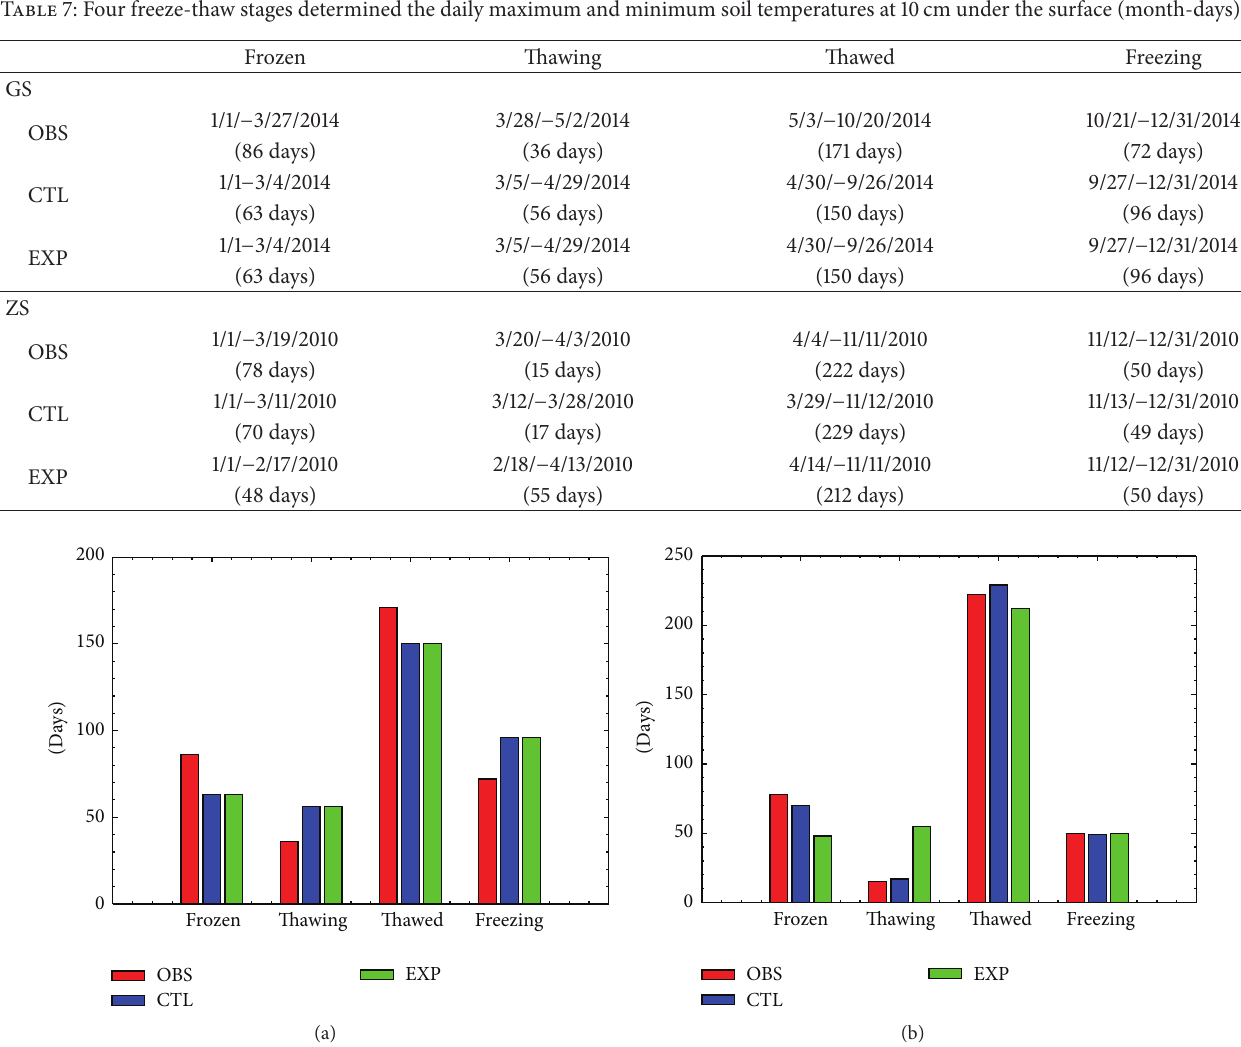
Figure 9: Observed and simulated days in each freezing and thawing stage at different sites. (a) is for the GS site. (b) is for the ZS